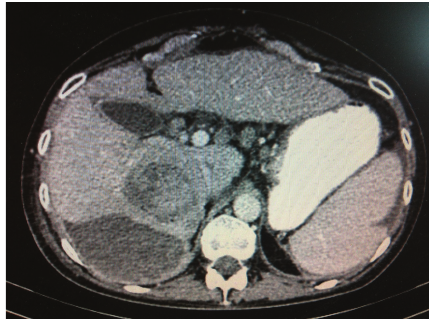
Figure 1: A three-phase CT of the abdomen. In a 4-segment focal lesion with typical enhancement in contrast phase and washout effect in a venous